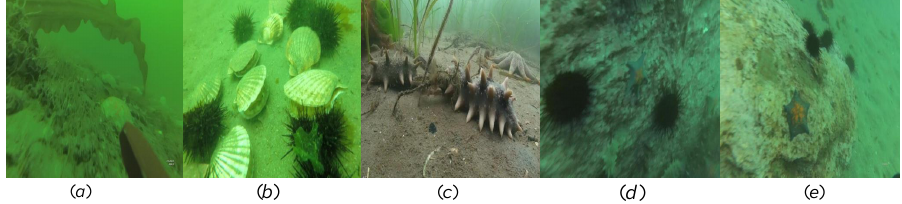
Figure 12. URPC2019 dataset includes five biological categories, namely ( a ) waterweeds, ( b ) scallop, ( c ) holothurian, ( d ) echinus and ( e ) starfish.